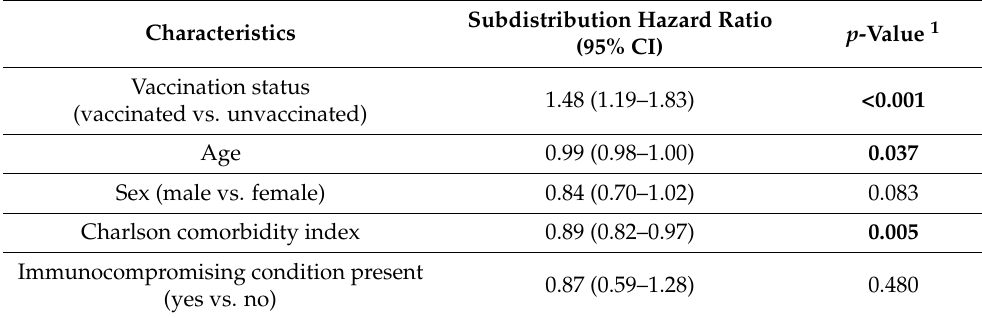
Table 3. Subdistribution hazard ratios for discharge from the hospital.